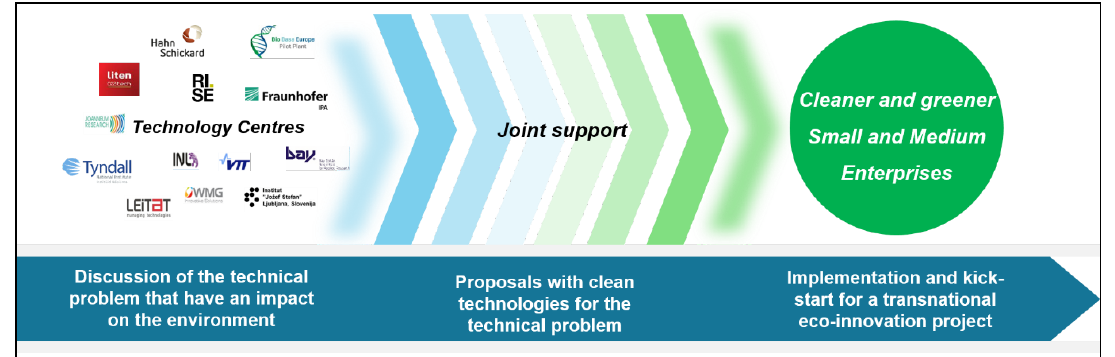
Figure 5. Overview of the open-eco-innovation process .